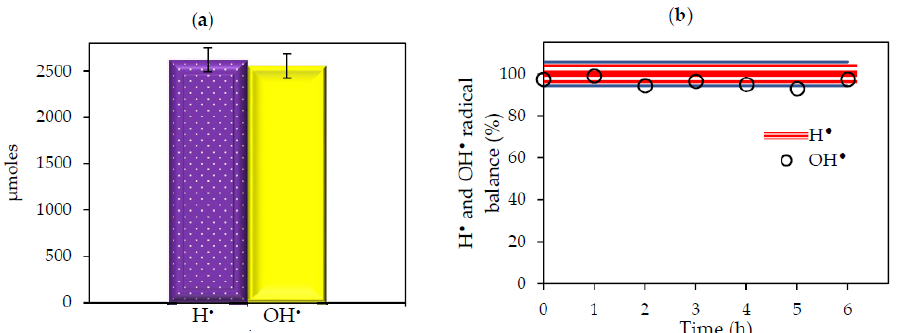
Figure 12. ( a ) Moles of OH • and H • radicals formed after 6 h of photocatalytic hydrogen production under visible light, and ( b ) percentual OH • and H • balances at different irradiation times under visible light. The 95% confidence and prediction intervals are reported in red and blue, respectively.